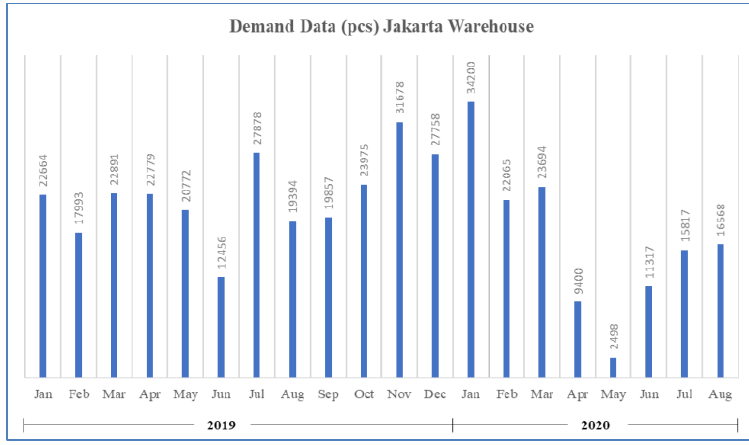
Figure 2: Demand Trend in 2019-2020 for Jakarta